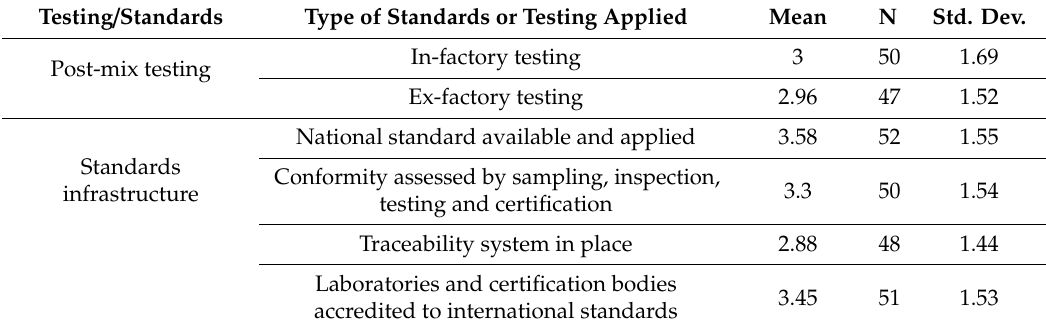
Table 4. Mean scores for post-mix testing / standards infrastructure (scored on scale, i.e., from 1—not available; to 5—available and fully functional).